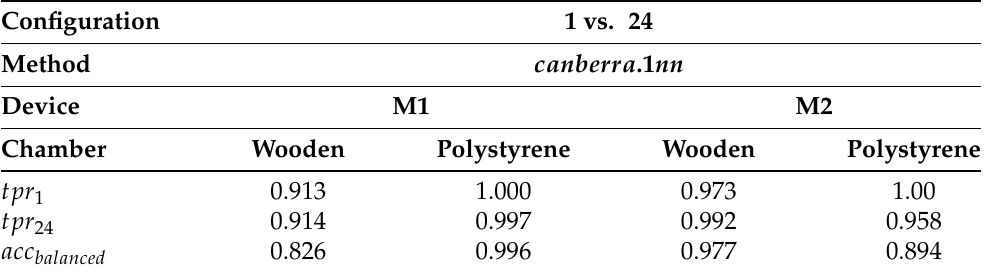
Table 11. The obtained tpr values for classes 1 and 24, and acc balanced in the validation tests of 5 × MCCV-5 in the comparison of 1 vs. 24 for the canberra .1 nn test, devices M1 and